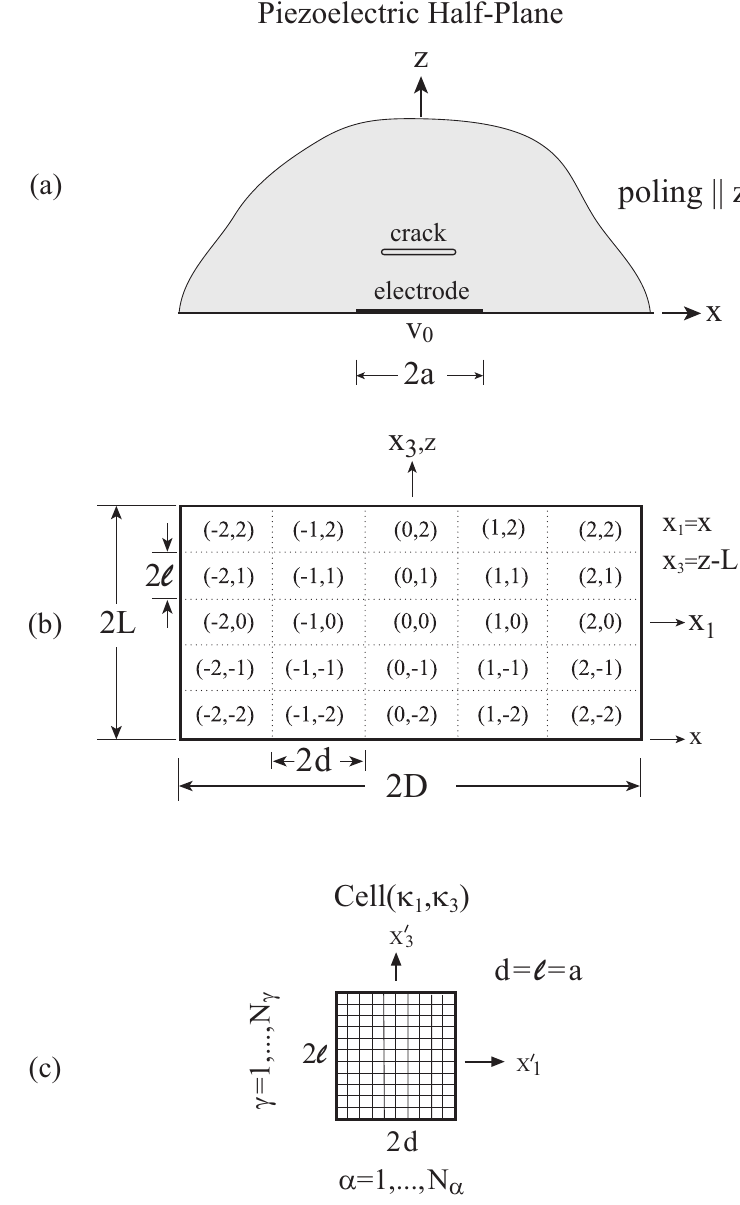
Figure 1. ( a ) A piezoelectric half-plane z ≥ 0 with an embedded short crack: An electrode of electric potential V 0 is attached to the half-plane surface z = 0 along − a ≤ x ≤ a . ( b ) A rectangular domain 2 D × 2 L of the composite is divided into several repeating cells. These cells are labeled by ( K 1 , K 3 ) with − M 1 ≤ K 1 ≤ M 1 and − M 3 ≤ K 3 ≤ M 3 , and the size of every one of which is 2 d × 2 l (the figure is shown for M 1 = M 3 = 2). ( c ) A representative cell in which local coordinates ( x (cid:48) for which origin is located at the center. The cell is divided into N α × N γ